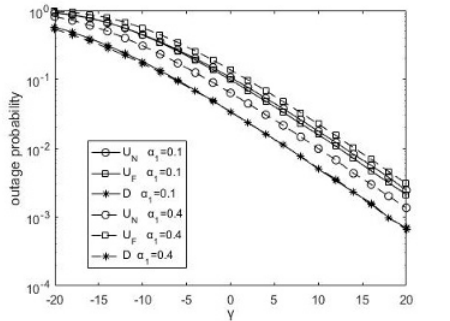
Fig. 1. outage probability against γ with 0.5,